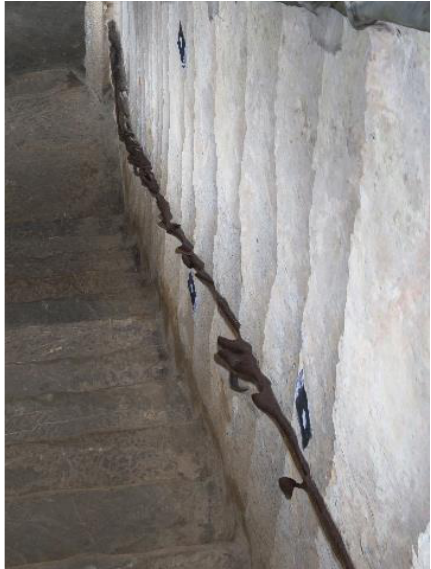
Figure 17: Result of 3D reconstruction from another point of